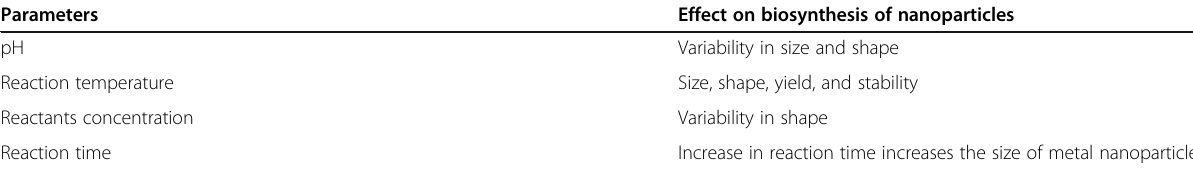
Table 3 Parameters manipulating the biosynthesis of nanoparticles